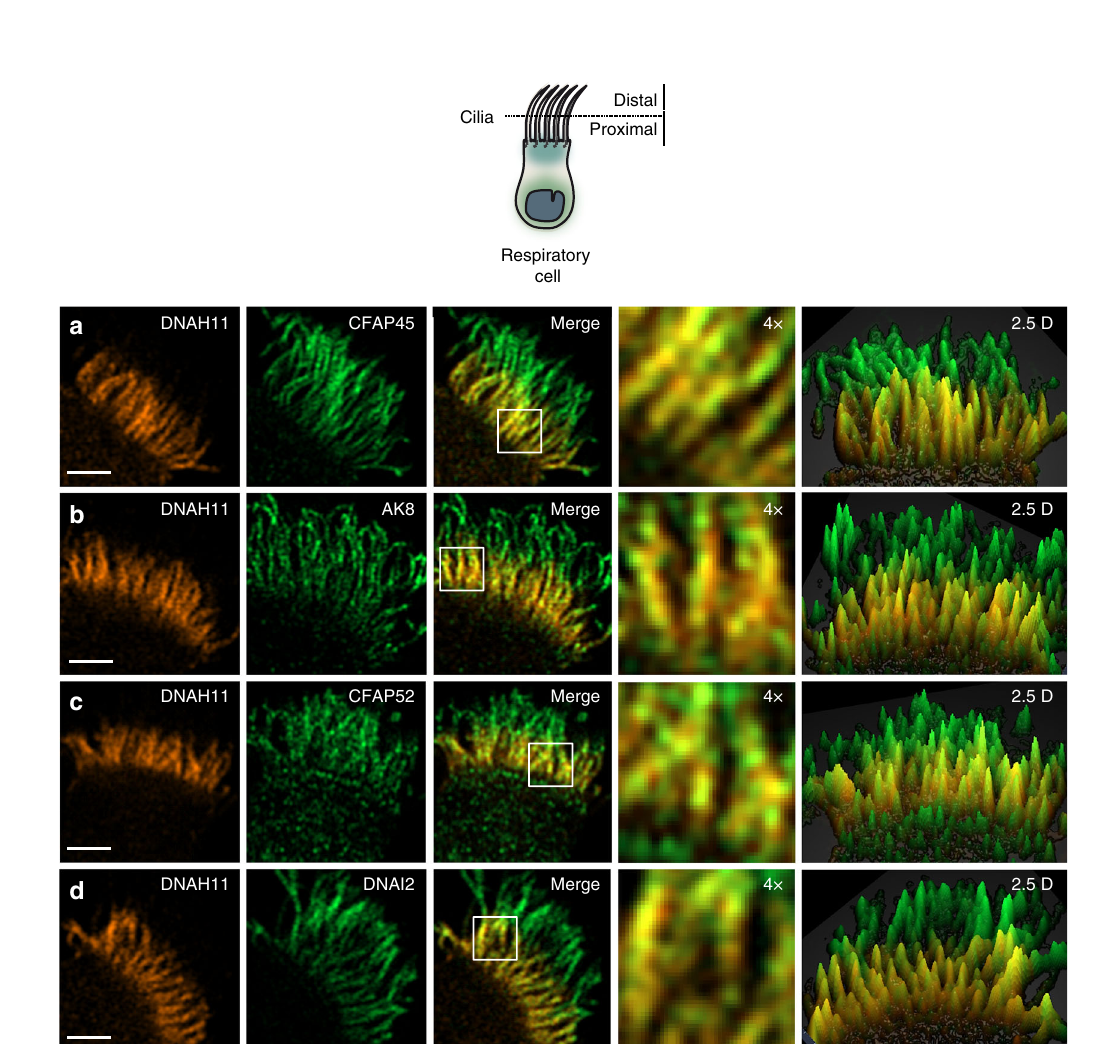
Fig. 6 CFAP45 and CFAP52 as well as AK8 colocalize with DNAH11 in the proximal region of respiratory cilia. High-resolution Airyscan imaging of healthy control respiratory cilia shows that DNAH11 colocalizes with CFAP45 ( a ), AK8 ( b ), and CFAP52 ( c ) as well as the ODA component DNAI2 ( d ) in the proximal ciliary region. Merge panels show colocalization (yellow) in the proximal ciliary region. DNAH11 (red) is detected using monoclonal anti- DNAH11; CFAP45, CFAP52, AK8, and DNAI2 (green) are detected using respective polyclonal antibodies at a fi nal concentration of 0.25 µ g/ml. Average colocalization coef fi cients with reference to DNAH11 (red, Alexa Fluor 546) are as follows: CFAP45, n = 15 from two experiments (0.564, 0.663 weighted), CFAP52, n = 13 from two experiments (0.878, 0.913 weighted), AK8, n = 13 from two experiments (0.799, 0.835), DNAI2, n = 15 from two experiments (0.760, 0.820 weighted). White scale bar equals 2 µ m. 4× indicates four times magni fi cation of the white box in merge panel, which represents two square microns. Two and a half dimensional (2.5D) representations show intensity values as projections in the Z -axis (grid distance